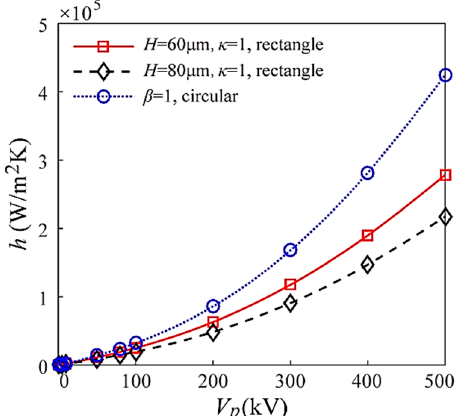
Figure 3. Effect of applied voltage on the average convective heat transfer coefficient of EOF in the Y- Figure 3. E ff ect of applied voltage on the average convective heat transfer coe ffi cient of EOF in the shaped microchannels with different geometries and configurations. Y-shaped microchannels with di ff erent geometries and configurations.